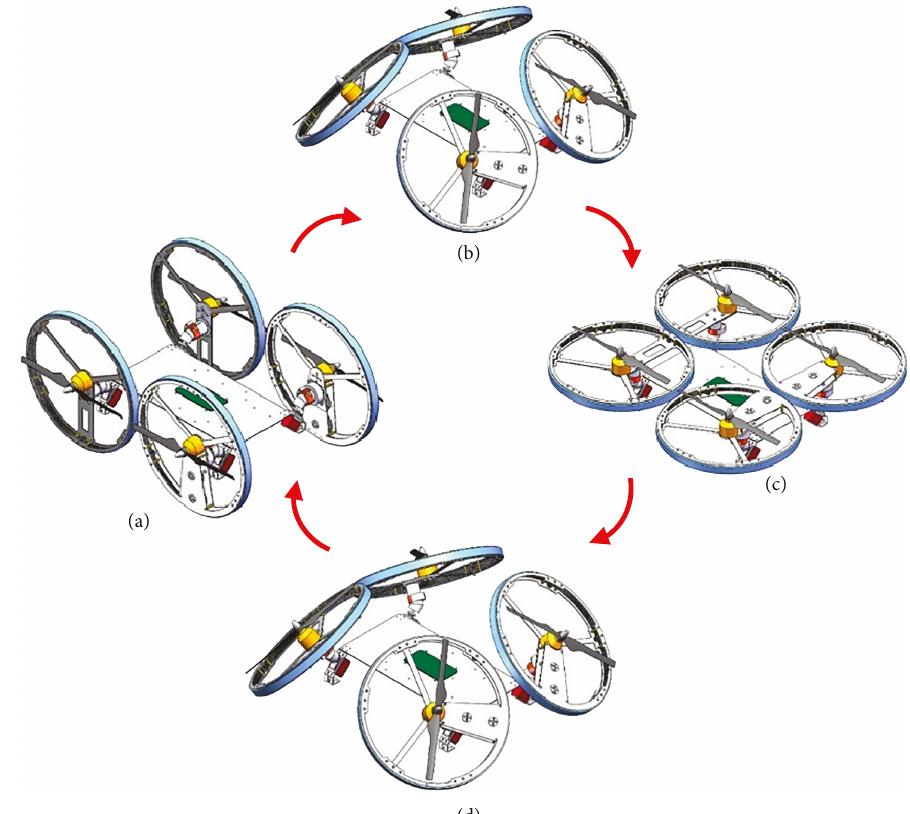
Figure 1: The full sequence of